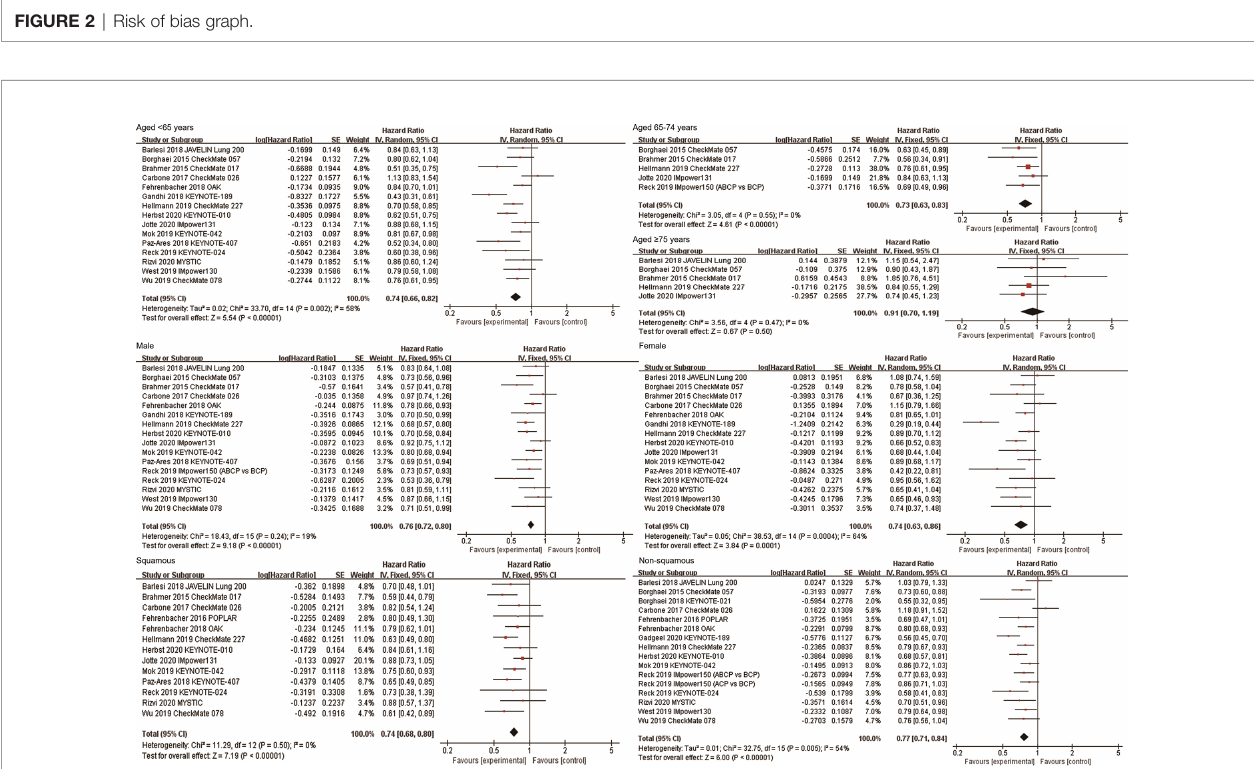
FIGURE 3 | Forest plots of hazard ratios comparing overall survival between patients treated with anti-PD-1/PD-L1-based therapy or non-ICI therapy according to age, sex, and histological type. PD-1, programmed death-1; PD-L1, programmed death-ligand 1; ICI, immune checkpoint